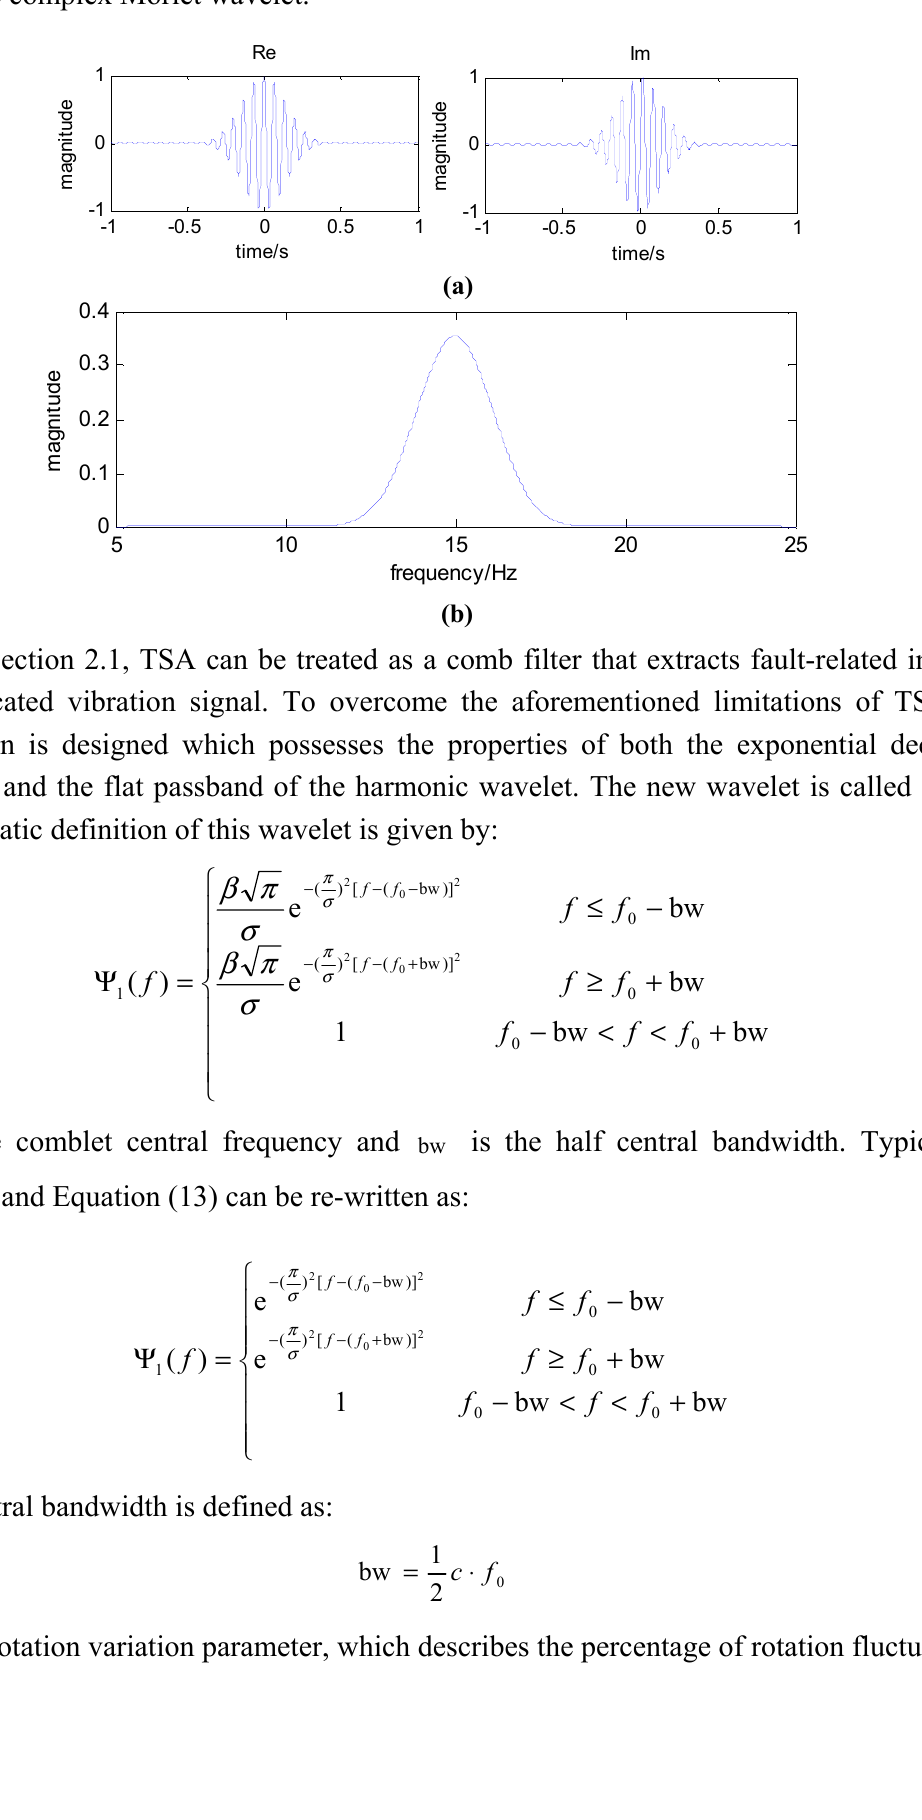
Figure 1. ( a ) Time-domain plot of the complex Morlet wavelet; ( b ) Frequency-domain plot of the complex Morlet